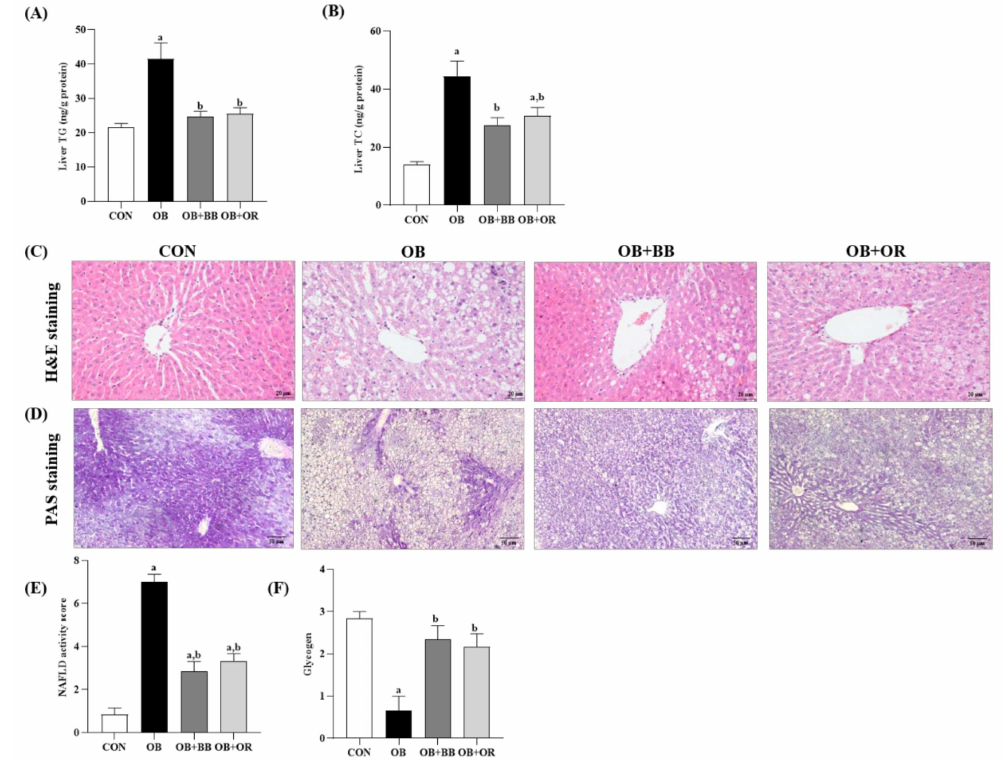
Figure 2. Effect of bee bread on liver lipid levels and hepatic steatosis. ( A ) Liver TG level, ( B ) liver TC level, ( C ) H&E staining (magnification × 400, scale bars represent 20 µ m) and ( D ) PAS staining (magnification × 100, scale bars represent 50 µ m) analyses of liver, ( E ) NASH scoring, and ( F ) glycogen scoring of rats in all experimental groups. Values are presented as mean ± SEM, n = 8/group. CON, control; OB, obese; OB + BB, obese + bee bread 0.5 g/kg body weight/day; OB + OR, obese + orlistat 10 mg/kg body weight/day; TG, triglyceride; TC, total cholesterol. One-way ANOVA, followed by Tukey post-hoc test. a p < 0.05 vs. CON group, b p < 0.05 vs. OB